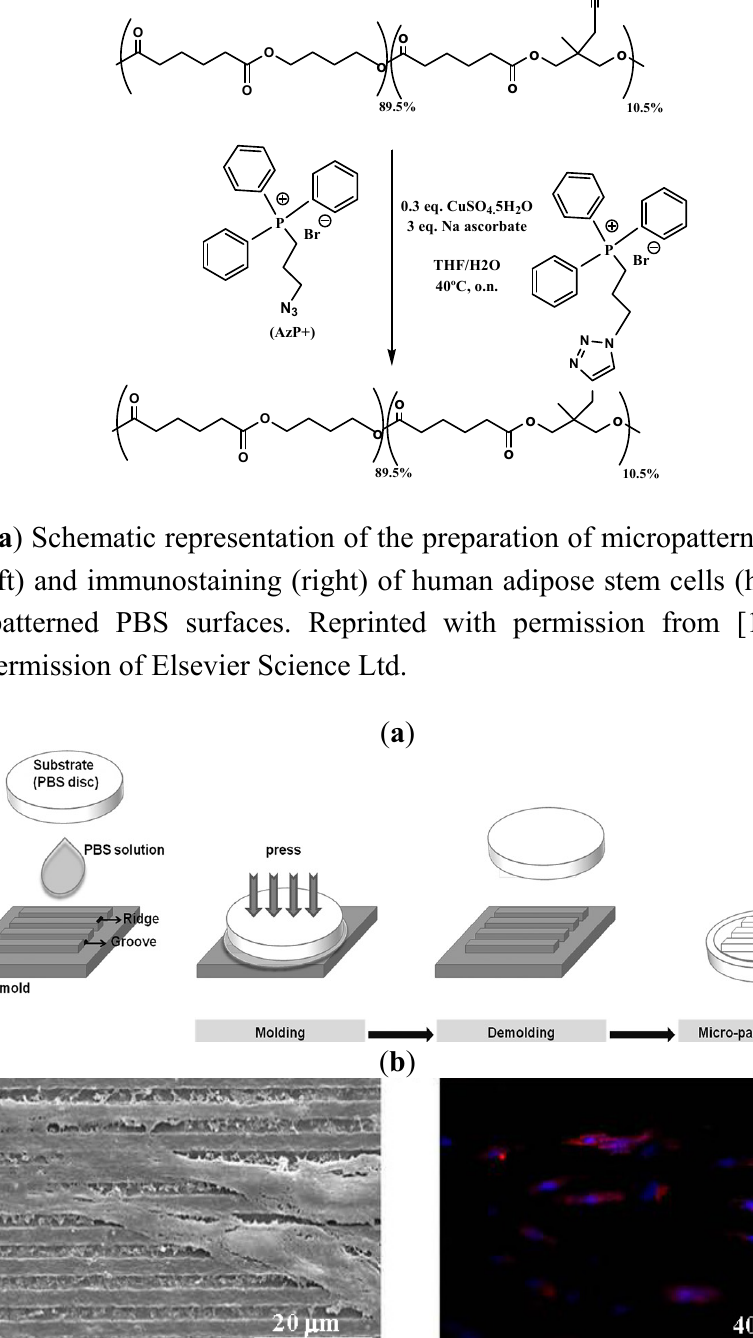
Figure 13. Synthetic of poly(butylene adipate) functionalized with quaternary phosphonium groups, based on [176]. The alkyne-containing polyester was prepared from 1,4-butanediol, the alkyne-containing diol 2-methyl-2-propargyl-1,3-propanediol and adipic acid.